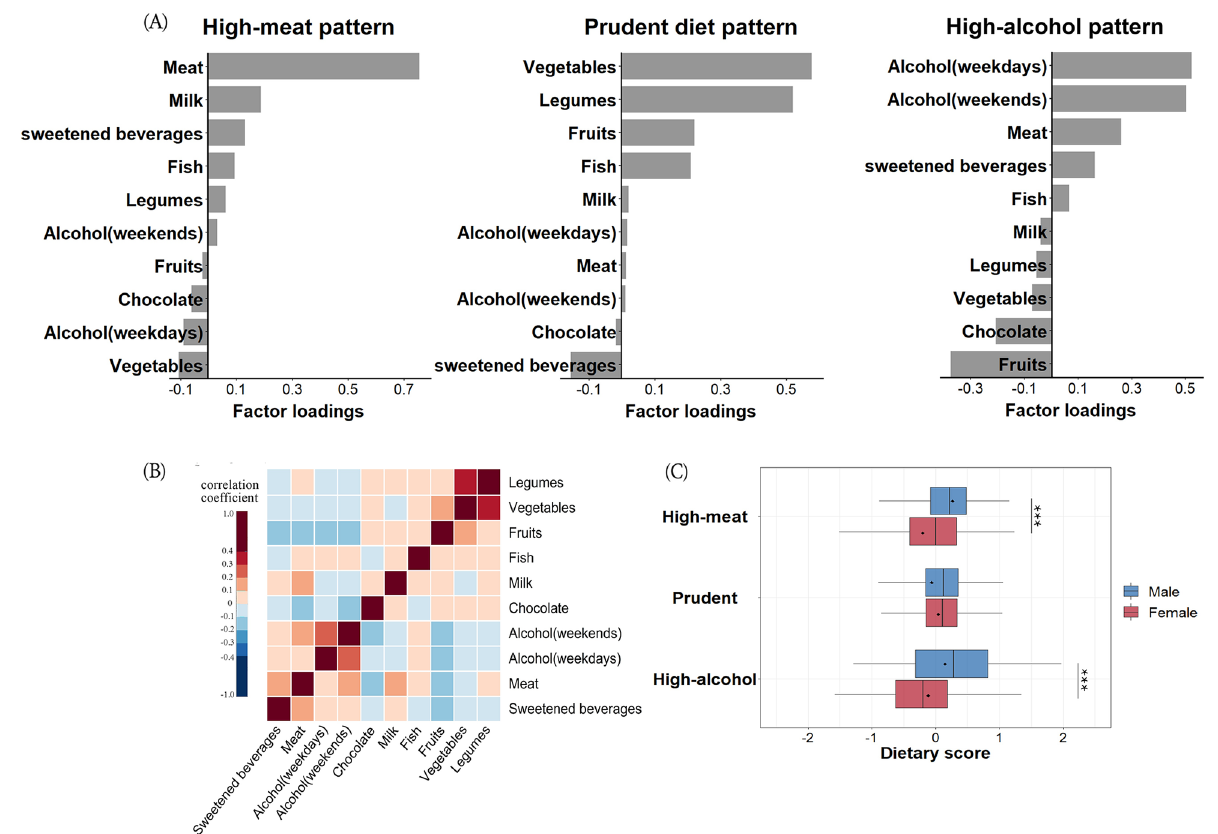
Figure 1. Dietary patterns derived by polychoric correlation analysis. ( A ) Factor loadings for the 10 food groups used in the extraction of the most common dietary patterns among all subjects (n = 482). In high-meat pattern, meat consumption has the highest loading (0.754); In prudent diet pattern, the top four loadings were vegetables (0.575), legumes (0.519), fruit (0.220) and fish (0.209); In high-alcohol consumption, daily (0.522) and weekend (0.503) alcohol consumption weighted the highest. Factor loadings were derived by polychoric correlation with varimax rotation. ( B ) Correlation matrix shows paired correlations of all food items with hierarchical clustering. Red color indicates positive correlations and blue color indicates negative correlations. ( C ) Boxplots show the differences of scores of three dietary patterns between men and women by Wilcoxon test, ***: P <